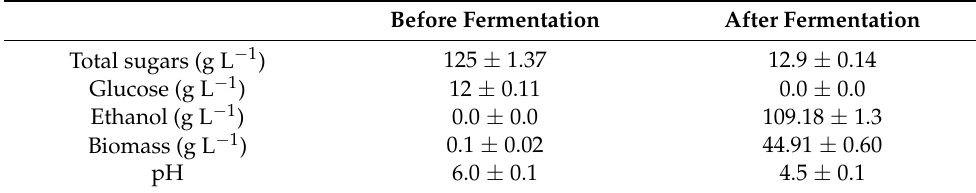
Table 3. Characteristics of the wort before and after fermentation.